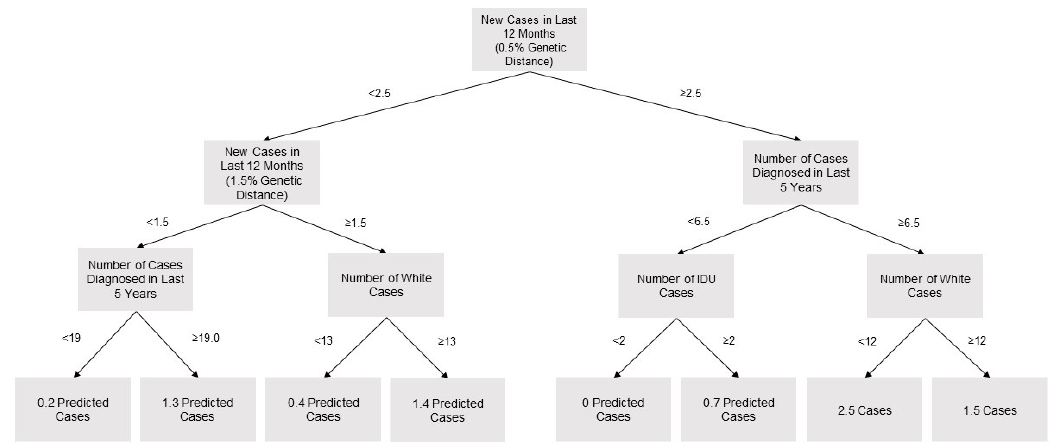
Figure 1. Four layer sample tree from 500-tree random forest model to predict three-month cluster growth, Washington State